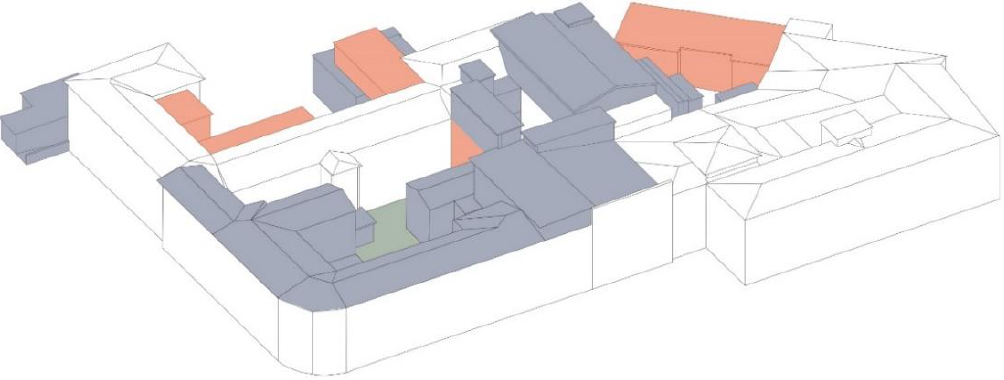
Figure 11. Superfluous additions are in purple and design incompatibilies in orange.